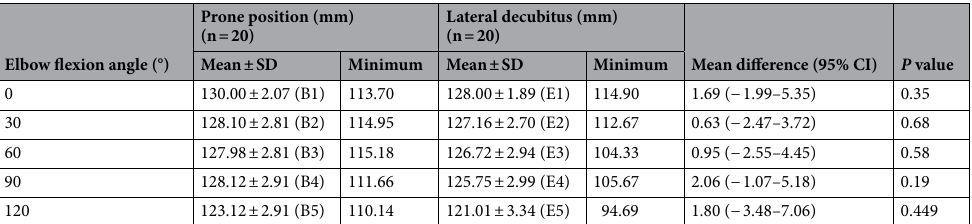
Table 1. Distances from the upper olecranon to the center of the radial nerve in the posterior shaft of the humerus.